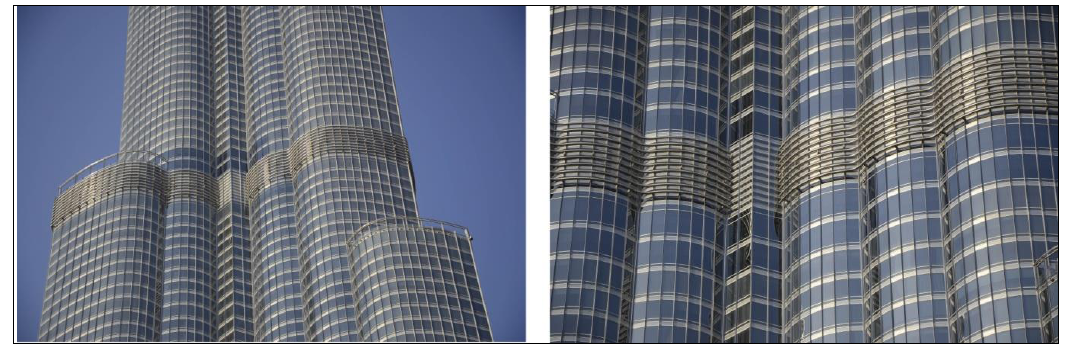
Figure 14. Burj Khalifa: Facade-reflective glazing with aluminum and textured stainless steel spandrel panels (photograph by authors).